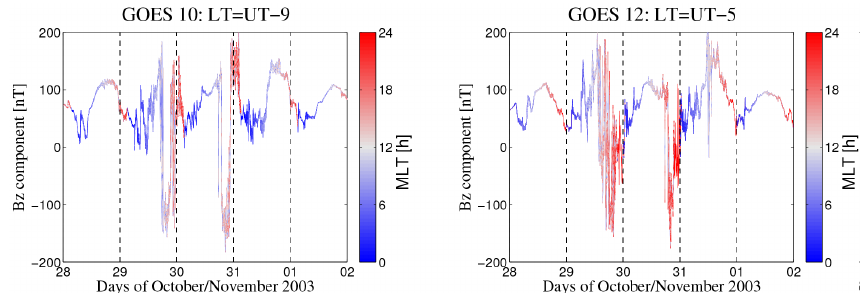
Figure 13. Halloween super storm, 28 October–1 November 2003: magnetospheric observations of the B z component in geosynchronous orbit for GOES10 (LT = UT − 9; left panel) and GOES12 (LT = UT − 5; right panel) spacecraft. The time resolution is 1min. GOES 10 Bz component −1000100 ( t ) C 1 −1000100 ( t ) C 2 50 −500 ( t ) C 3